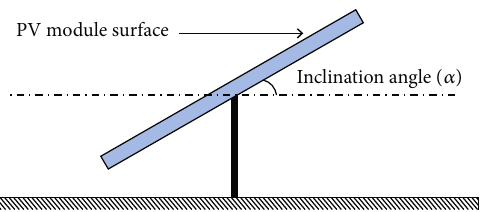
Figure 2: PV fi eld orientation.